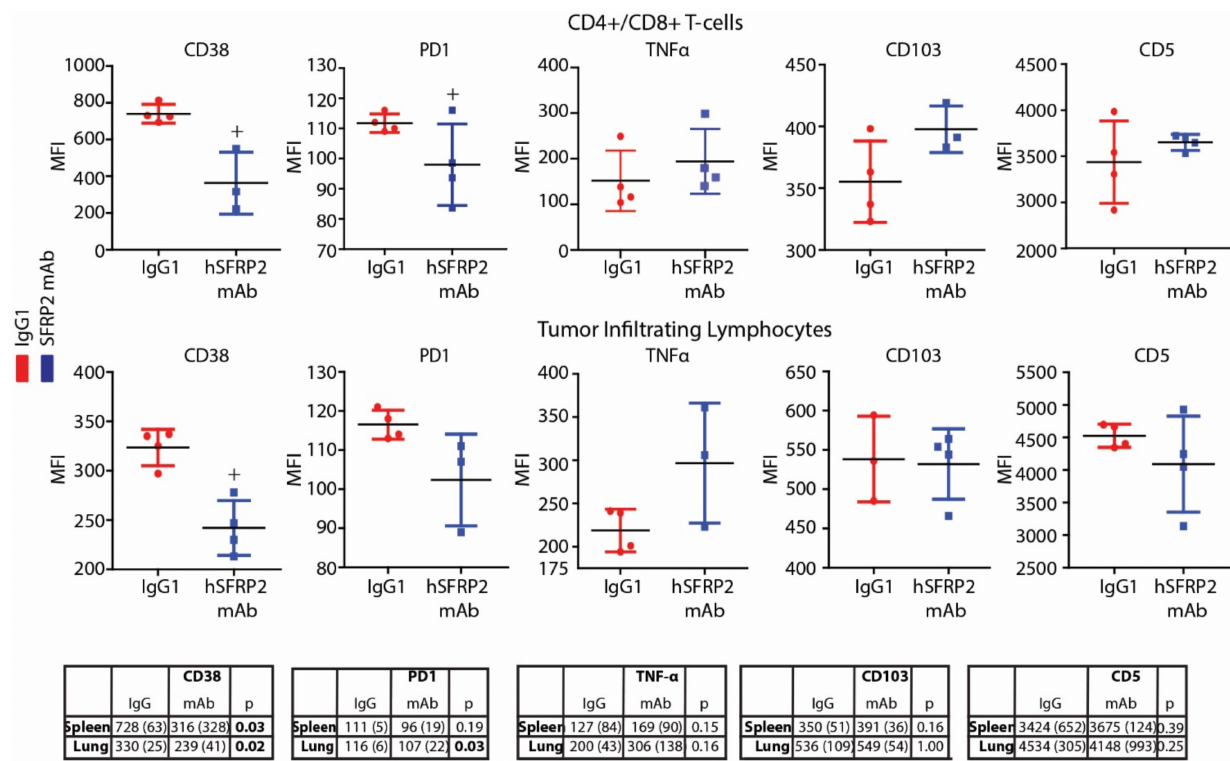
Figure 4. hSFRP2 mAb reduces T-cell CD38 and PD-1 protein in vivo. Splenic CD4 + and CD8 + T-cells ( top ) and tumor infiltrating lymphocytes (TILs; bottom ) isolated from RF420 tumor-bearing mice treated with IgG1 control ( red ) or hSFRP2 mAb ( blue ) for 21 days were stained for the following immune markers labeled with fluorochromes: CD38, PD-1, TNF- α , CD103 and CD5. Dot plot graphs show mean fluorescent intensity (MFI) analyzed by FACS for each of the immune markers of interest within the CD4 + /CD8 + and TIL populations. For IgG1 and hSFRP2 mAb treatments, the number of independent samples (n) was 4. CD38 was significantly decreased with hSFRP2 mAb in both splenocytes (+ p < 0.05) and TILs (+ p < 0.05). PD-1 was significantly decreased in CD8 + TILs treated with hSFRP2 mAb (+ p < 0.05). Bottom tables: median MFIs (interquartile range) for each immune marker.